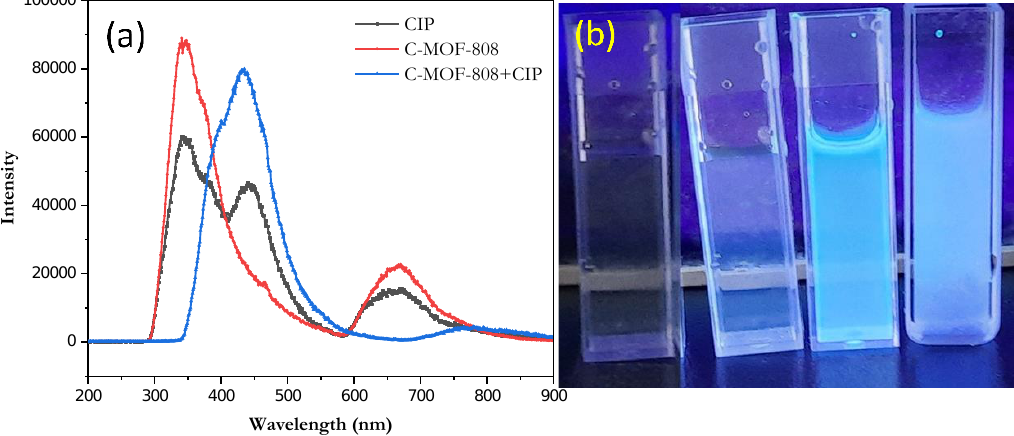
Figure 6. ( a ) Fluorescence spectra of receptor, CIP, and their mixture ( λ ex = 310 nm) and ( b ) real images of the aqueous solution of receptor with increasing concentration of CIP under UV-light.